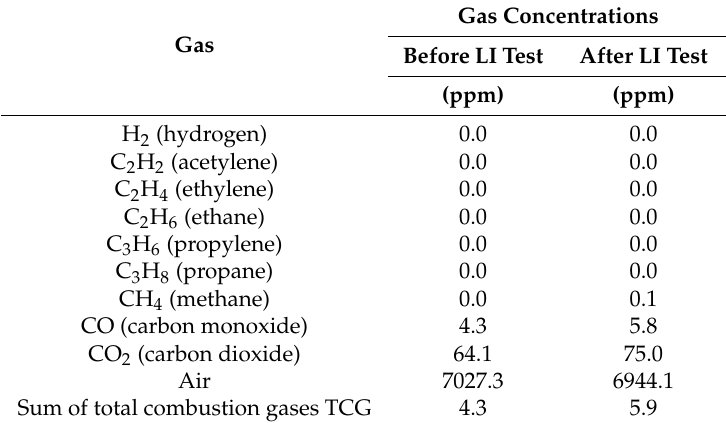
Table 6. Gas concentrations measured for the oil samples taken from the transformer tank before and after the lightning impulse (LI) test.